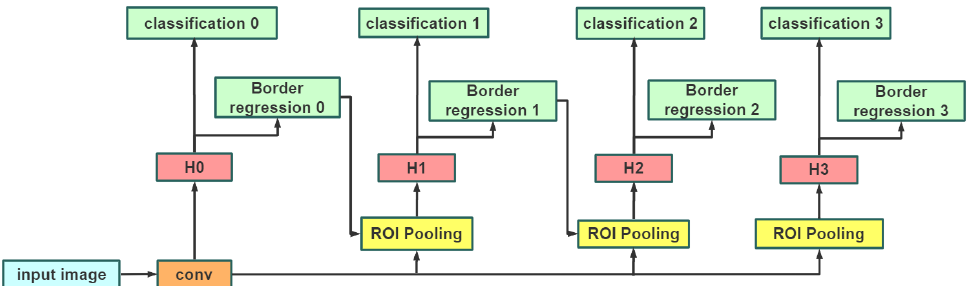
Figure 4. Framework of cascade R-CNN.